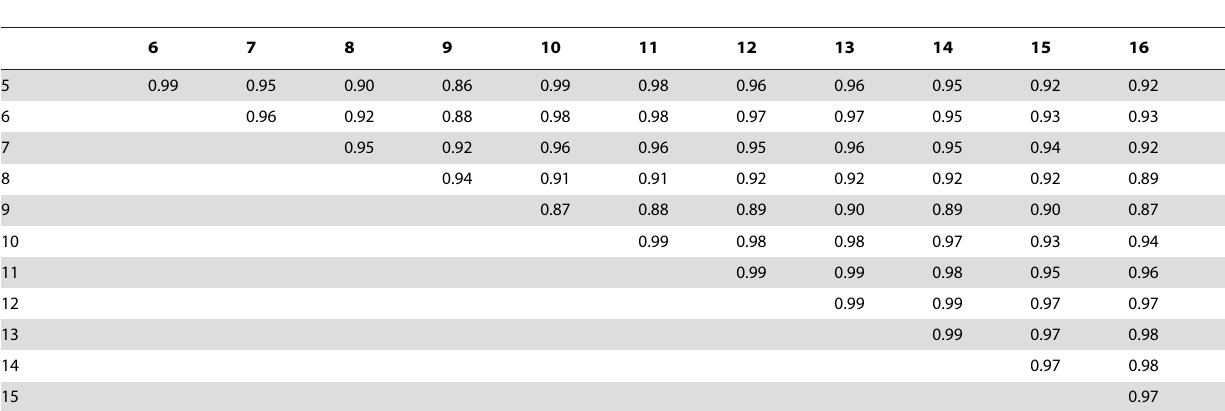
Table 2. Correlations between the CASI